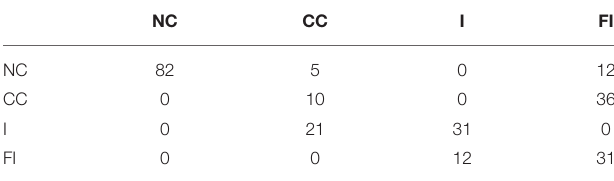
TABLE 6 | Overall accuracy (100 times split) of the HMM models with PAA and